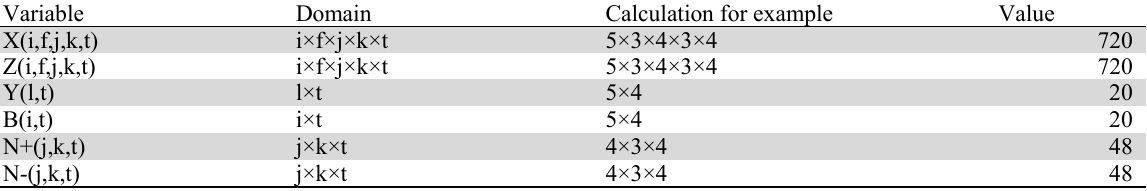
Variables and domains of the proposed model